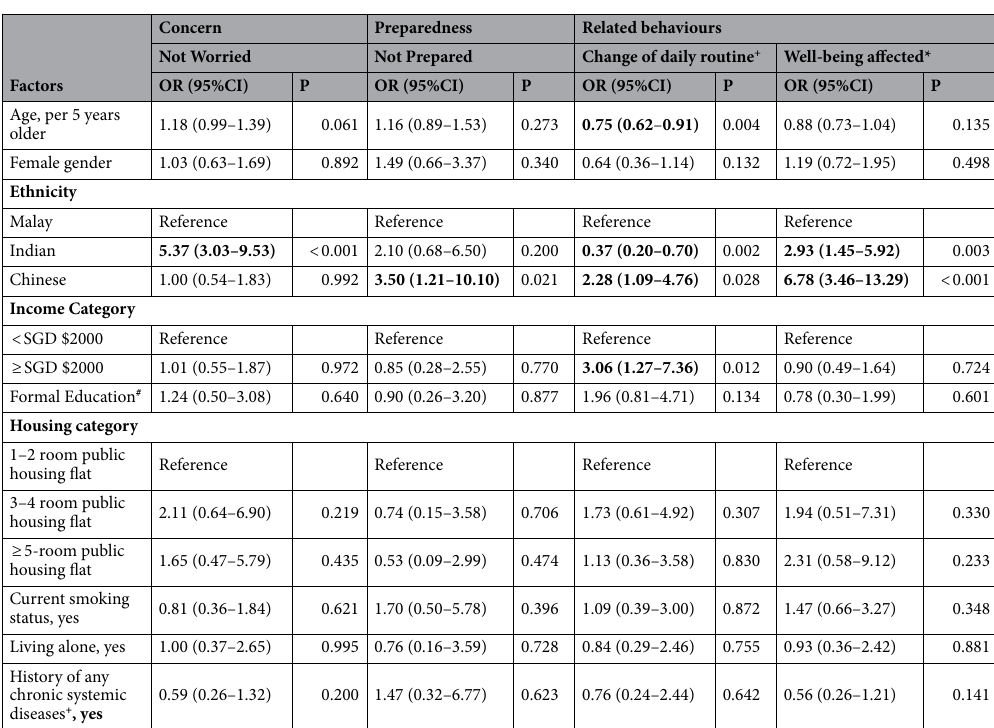
Table 3. Association between demographic, socio-economic factors and medical history with levels of concern, preparedness and behaviours related to COVID-19. SGD = Singapore Dollar. + Answered either ‘A Little’, ‘Moderate’ or ‘A lot’ on change in daily routine. *Answered either ‘More than usual’ or ‘Much more than usual’, for at least one of the questions on well-being impacted. # Defined as having primary or higher education. + Defined as having diabetes, hypertension, chronic kidney disease, cardiovascular disease or